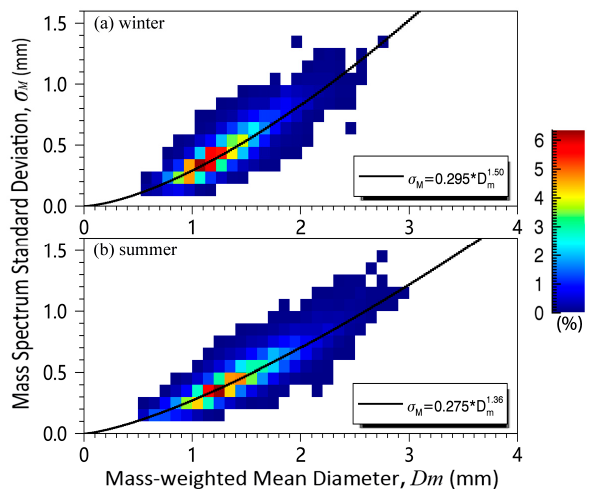
Figure 4. σ M – D m two-dimensional PDF distributions and fitting results based on Parsivel disdrometer observations in two seasons. The resolution of PDF is 0.1 mm × 0.1 mm and the color mark value represents the frequency of occurrence (%) of σ M versus D m .